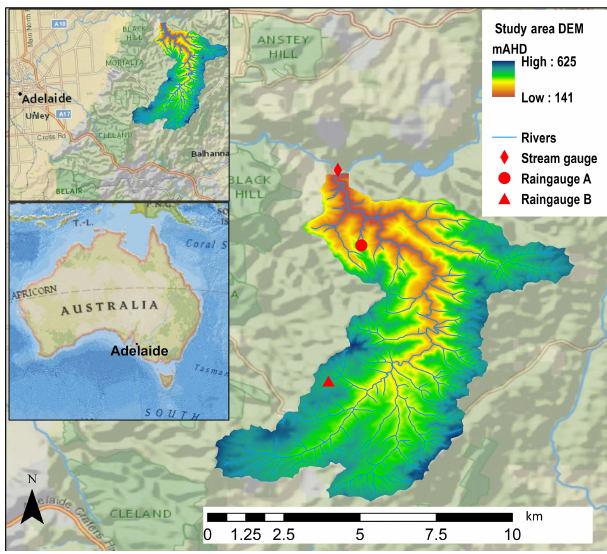
Figure 4. Digital elevation model of the Sixth Creek Catchment study area (Gallant et al.,